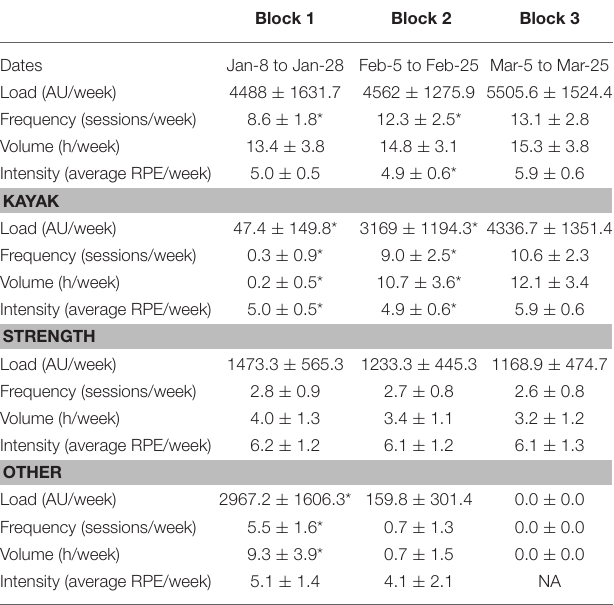
TABLE 1 | Training load in the 3-weeks training camp (block 3) and the two previous 3-weeks training blocks (blocks 1 and 2).